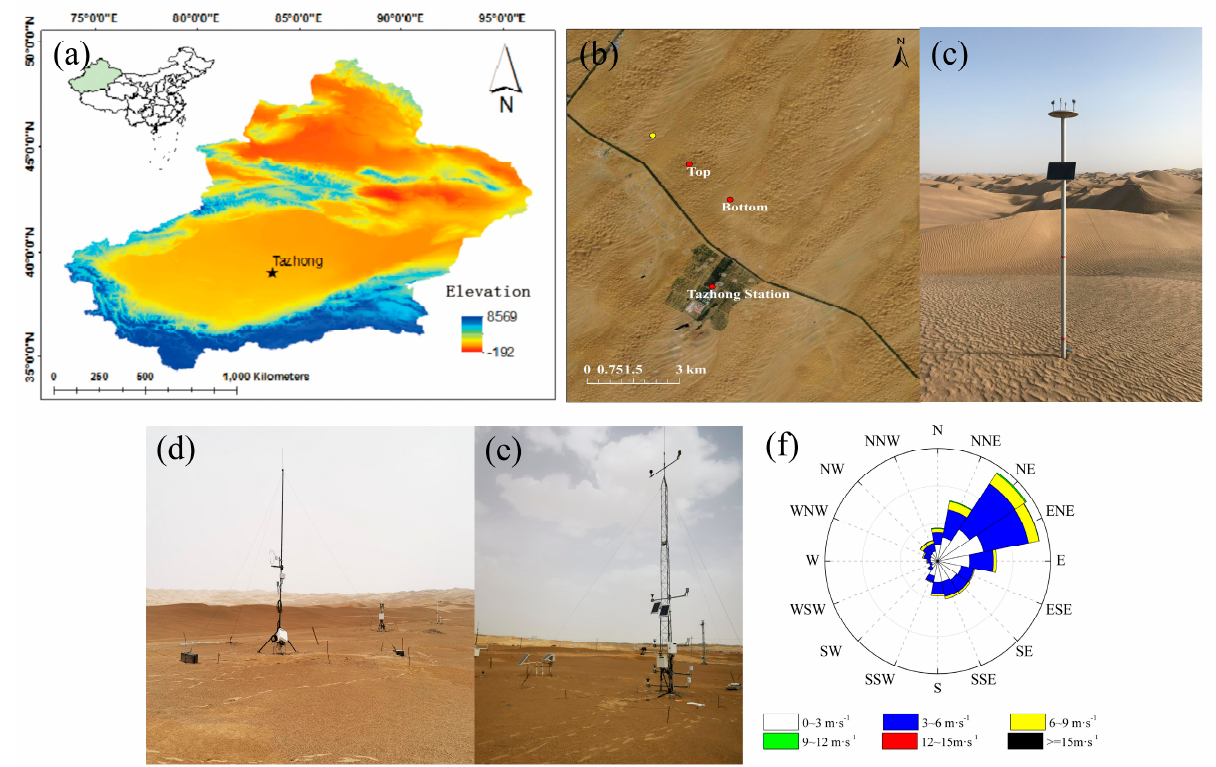
Figure 2. Location map ( a ); instrumentation for micrometeorological observations on the top and bo tt om of sand dunes in the TD (top: 39°00 ′ 11 ″ N, 83°39 ′ 06 ″ E, 1155.8 m.a.s.l.; bo tt om:38°59 ′ 35 ″ N, 83°39 ′ 49 ″ E, 1111.3 m.a.s.l.; Tazhong Station: 38°58 ′ 00 ″ N, 83°39 ′ 00 ″ E, 1099 m.a.s.l.) ( b , c ); the eddy correlation (EC) system ( d ); the 10 m meteorological parameter observation ( e ); and the prevailing wind direction ( f ). (Yellow dot is not observed at the bo tt om of shady slope of dune; the distance is approximately 2 km between the top and bo tt om sites).